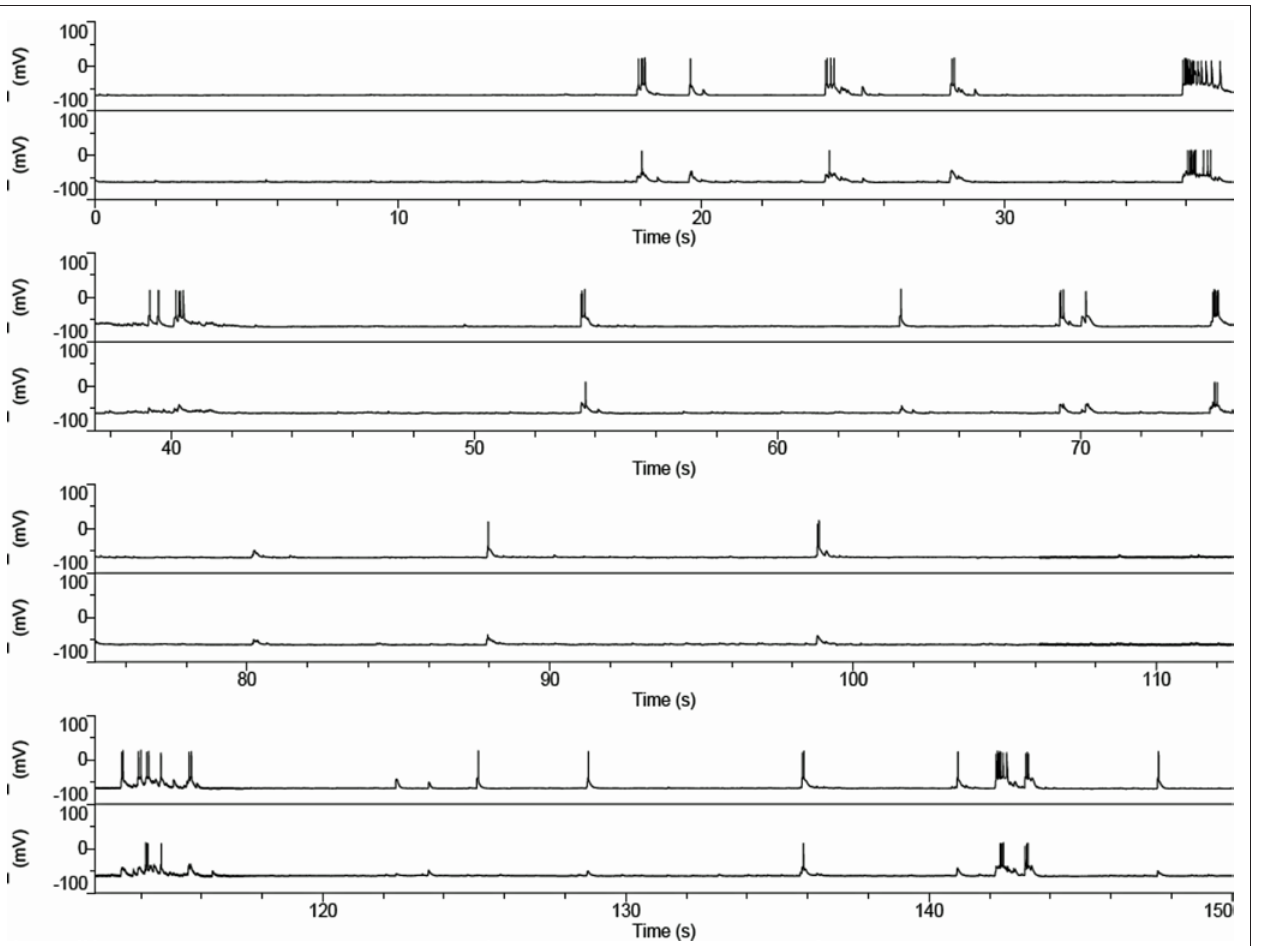
Figure 4 | Spontaneous activity in corticostriatal cultures. Current clamp records of a pair of cortical (upper trace) and striatal neuron firing patterns in culture show occasional bursts at about 0.1 Hz with “UP” states that last approximately 0.5 s. Although slower than the typical pattern in vivo the pattern is very reminiscent of that seen in the anesthetized rat (Wilson and Groves, 1981; Wilson et al., 1983). The records shown are continuously recorded